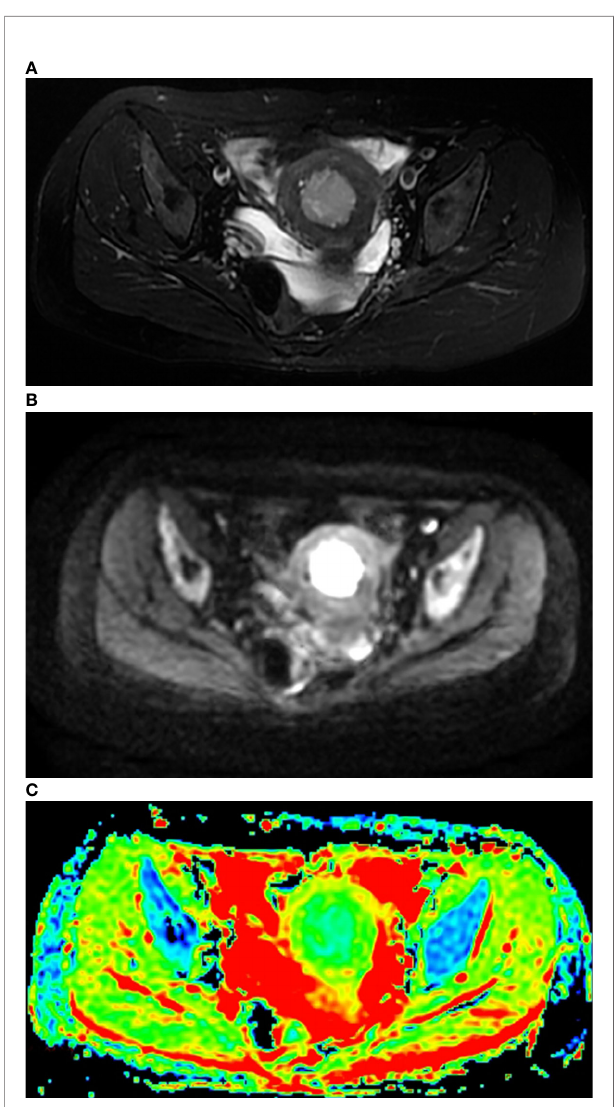
FIGURE 1 | T2WI (A) , DWI (B) and DW-ADC image (C) of